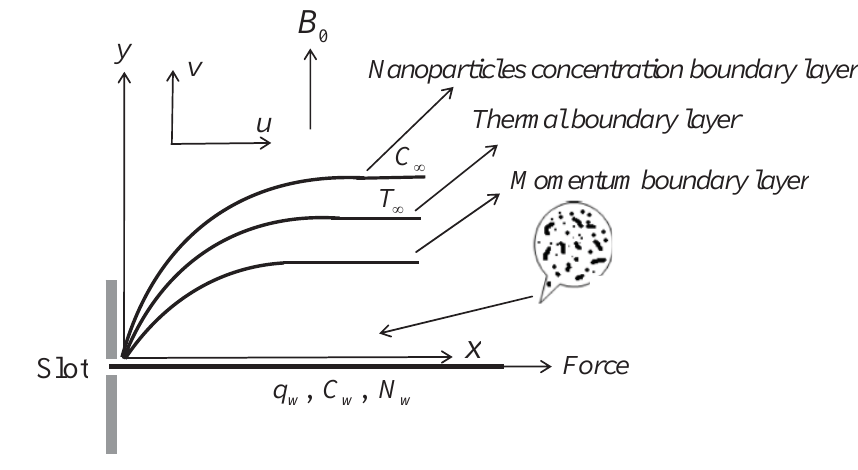
Figure 1. Schematic for the physical model